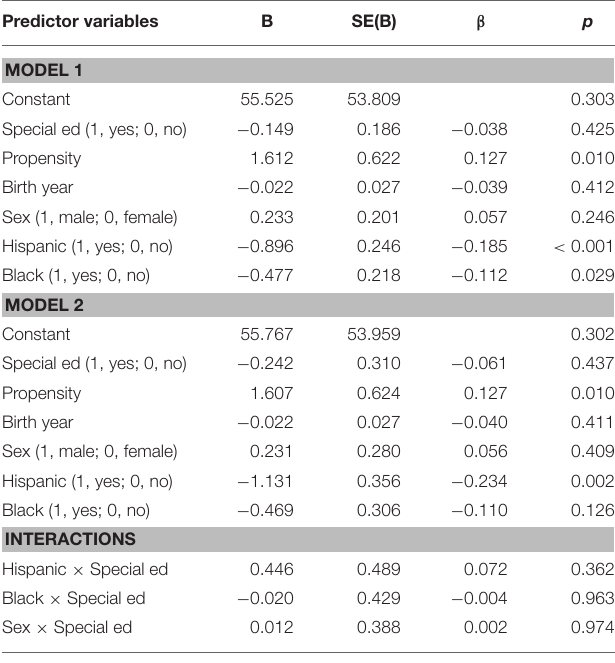
TABLE 5 | Hierarchical multiple logistic regression analyses predicting completion of high school diploma ( n =